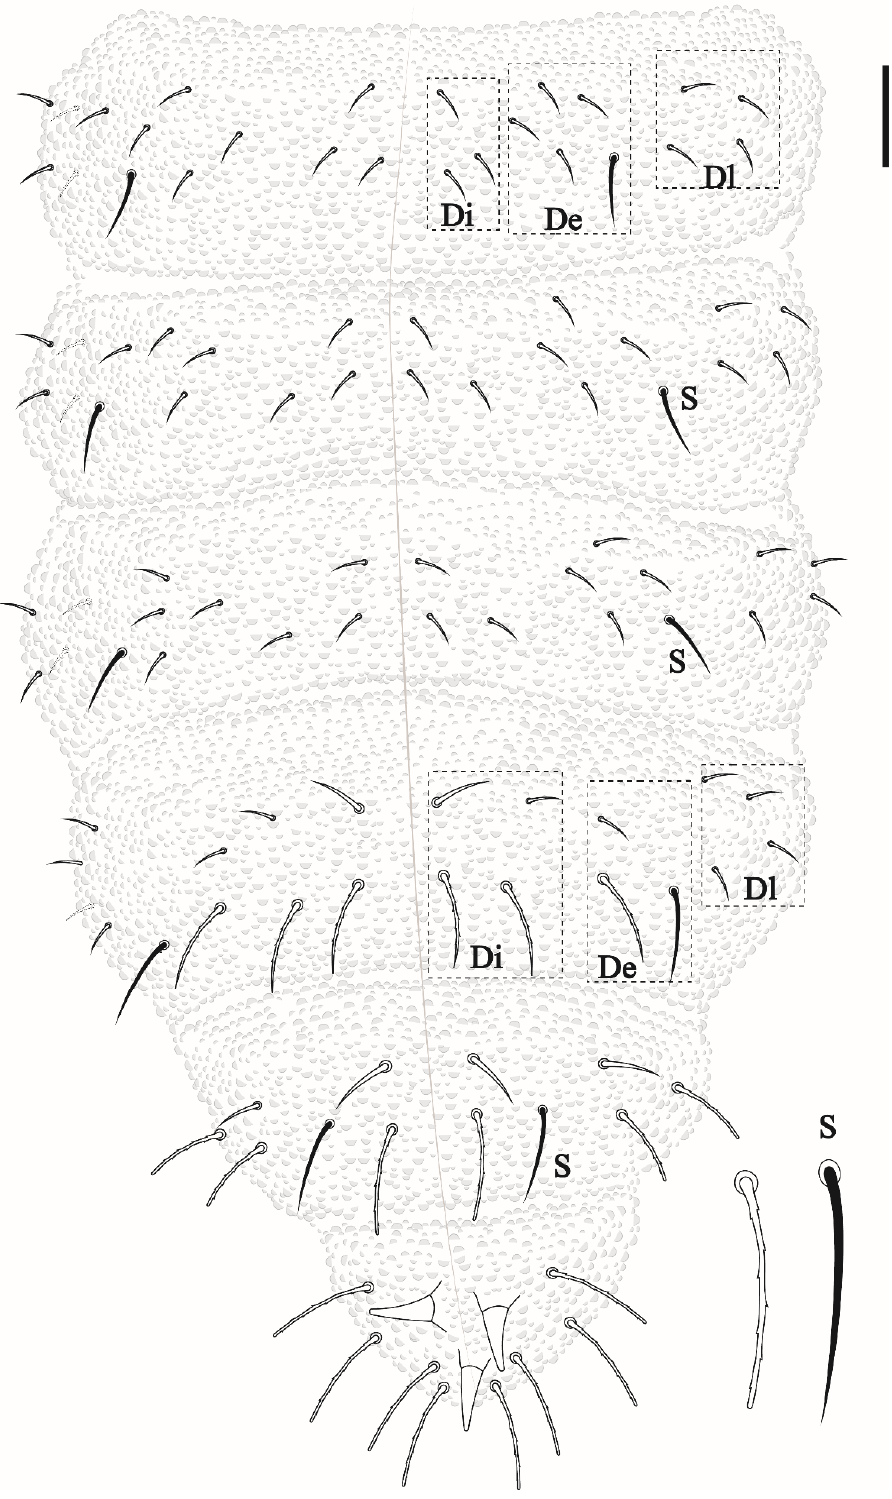
Figure 5. Friesea noronhaensis sp. nov. 8, dorsal view of abdominal segments I–VI. Scale bar 10 µm.